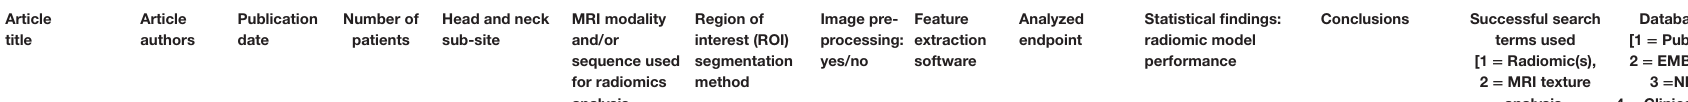
A three-step autosegmentation method leveraging, as a component, a trained kernel-based support vector machine (SVM) model successfully differentiated 100% of parotid volumes where the average percentage of volume differences between the proposed method and manual physician contours were 7.98% (left parotid) and 8.12% ( right parotid). Average Dice volume overlap: 91.1 ± 1.6% (left) and 90.5 ± 2.4% (right). Significant differences in volume reductions were found between 3-month and 1-year follow-up examinations ( p = 0.19) and between 6-month and 1-year follow-up examinations ( p =